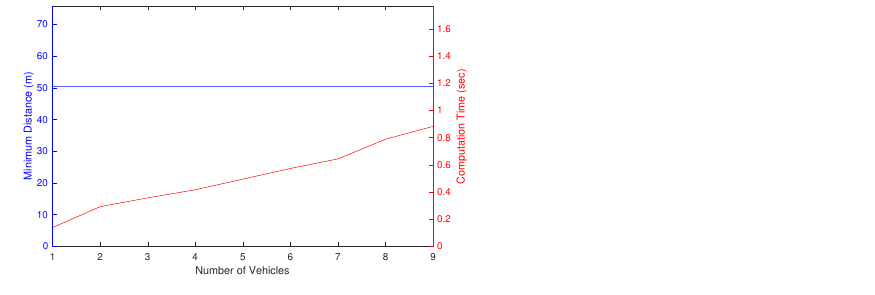
Figure 9. Effect of the number of intruders on the minimum distance and computation